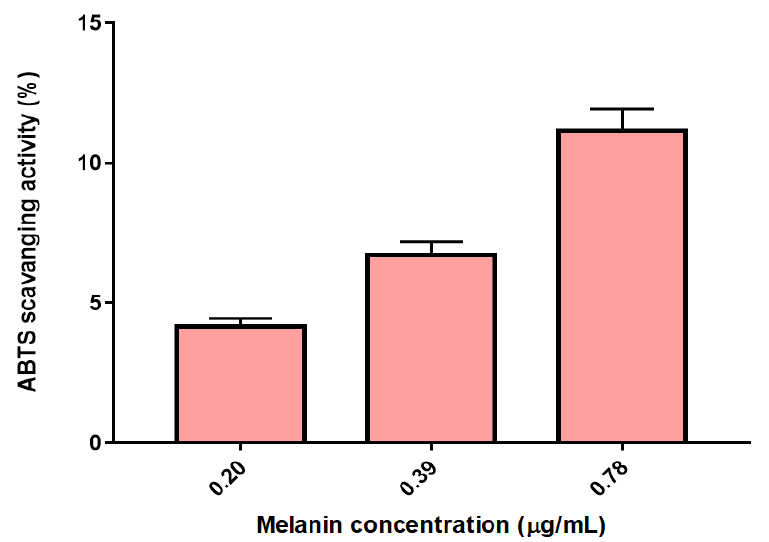
Figure 9. The scavenging ability of the extracted melanin produced by G. oxydans FBFS 97 on ABTS.